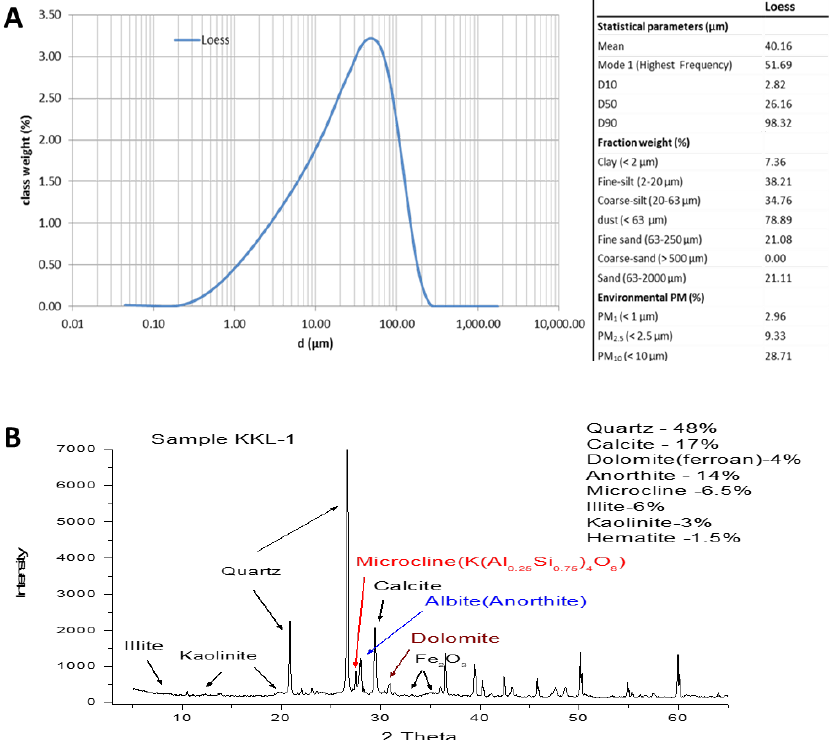
Figure 1. Characteristics of the Loess sample used for the experiments: ( A ) particle size distribution obtained by the laser diffractometer technique with the statistical parameters (right side). ( B ) Mineralogical composition of the loess by the X-ray power diffraction (XRPD). Table 1. List of products for dust control in the loess soil used in the laboratory experiment. The composition of the solution of each substance and the concentrations of the solution to be applied by spraying on the soil surface were provided by the suppliers and are typical in dust control. The geopolymer was prepared and applied as described in the text.